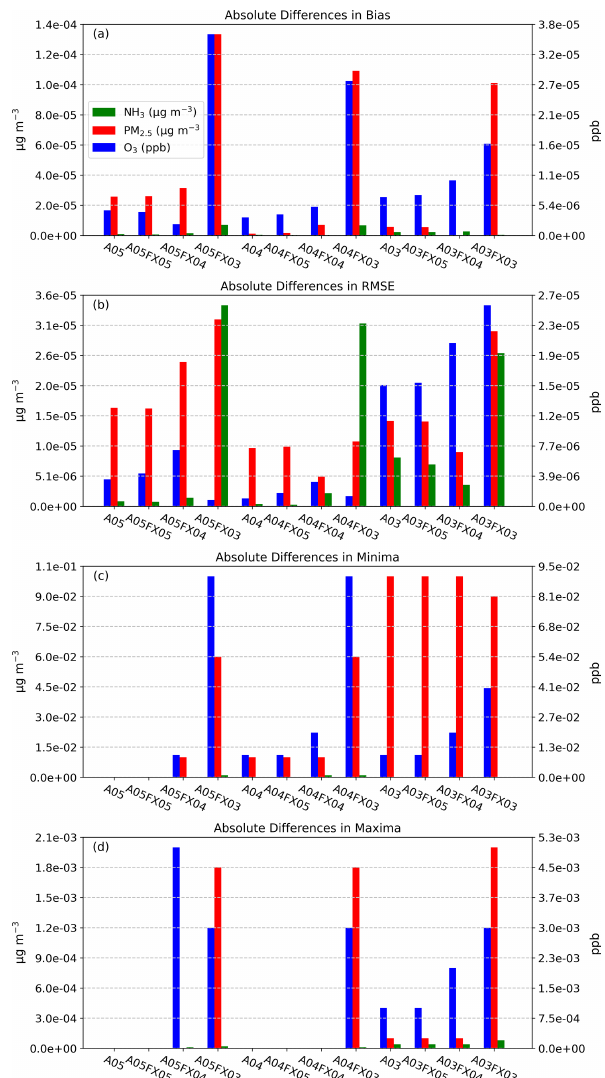
Figure 4. Absolute differences in bulk statistical metrics for daily PM 2 . 5 , MDA8 O 3 , and 2-week-averaged NH 3 between the orig simulation and the altered simulations and cases. Bulk statistical metrics were calculated for all model–observation pairs at in situ